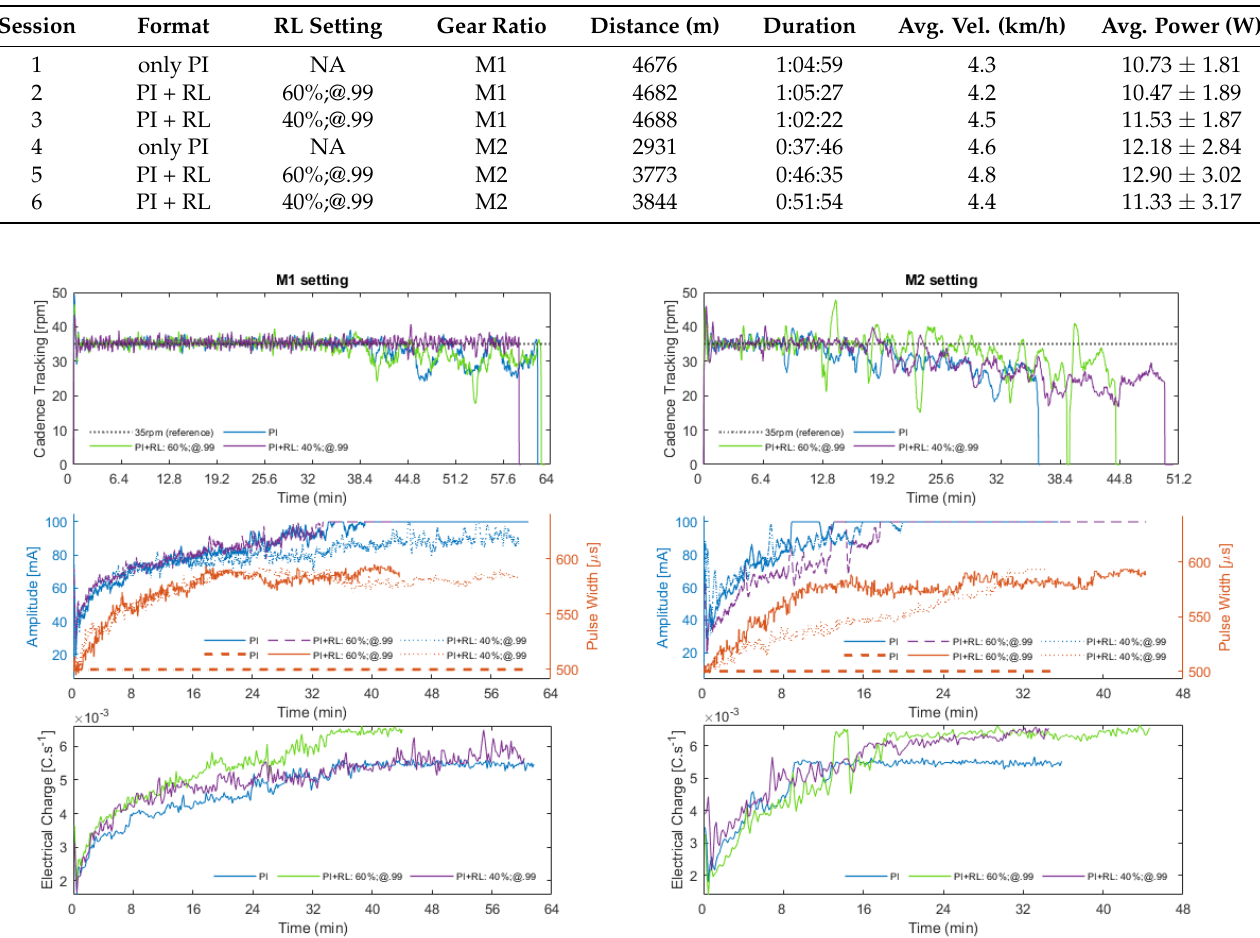
Table 1. Performance results for 6 different control techniques, using or not the RL algorithm. For the PI + RL format, “60%;@.99” means the agent is exploring new actions 60% of the time and decaying this percentage to 99% at the end of every episode. The “40%;@.99” format, in turn, represents a 40% exploratory rate, meaning the agent may choose to exploit actions most of the time instead of exploring new actions.